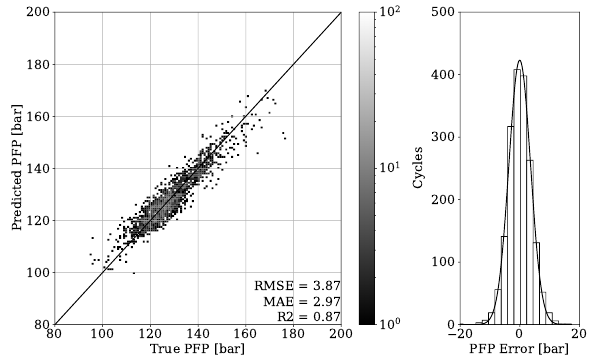
Figure 15. PFP regression of validation set from engine 2.